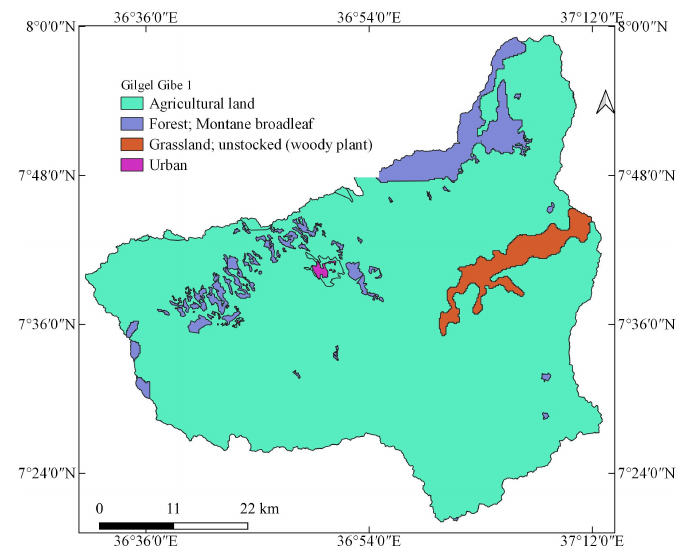
Figure 15. Land use map of the Gilgel Gibe 1 Watershed from 1989 to 2009.